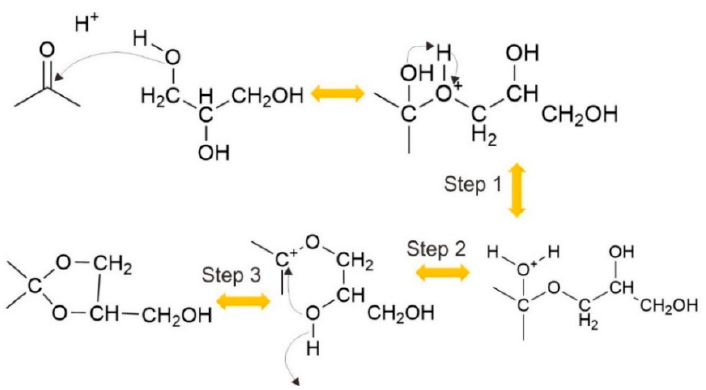
Figure 2. Scheme of mechanism for the ketalization reaction of glycerol and acetone.